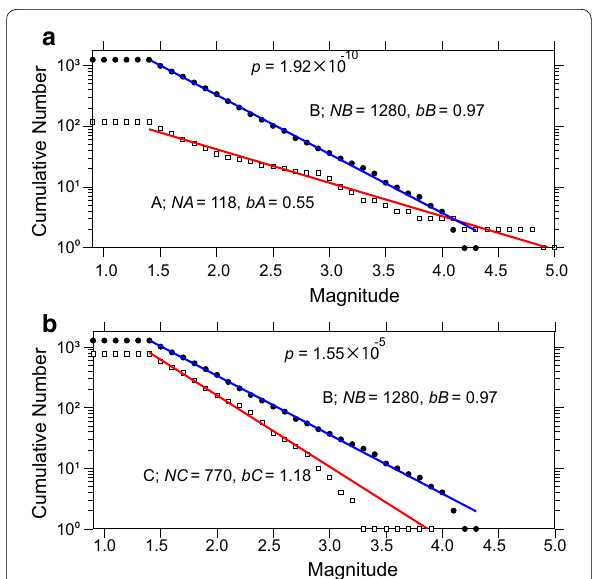
Fig. 5 a p -value test comparing a region of low b -values in central Shikoku district (region A, Fig. 4) with a region of moderate b -values in the Kii Channel (region B, Fig. 4). b p -value test comparing a region of high b -values in the Kii Peninsula (region C, Fig. 4) with a region of moderate b -values in the Kii Channel (region B, Fig. 4)